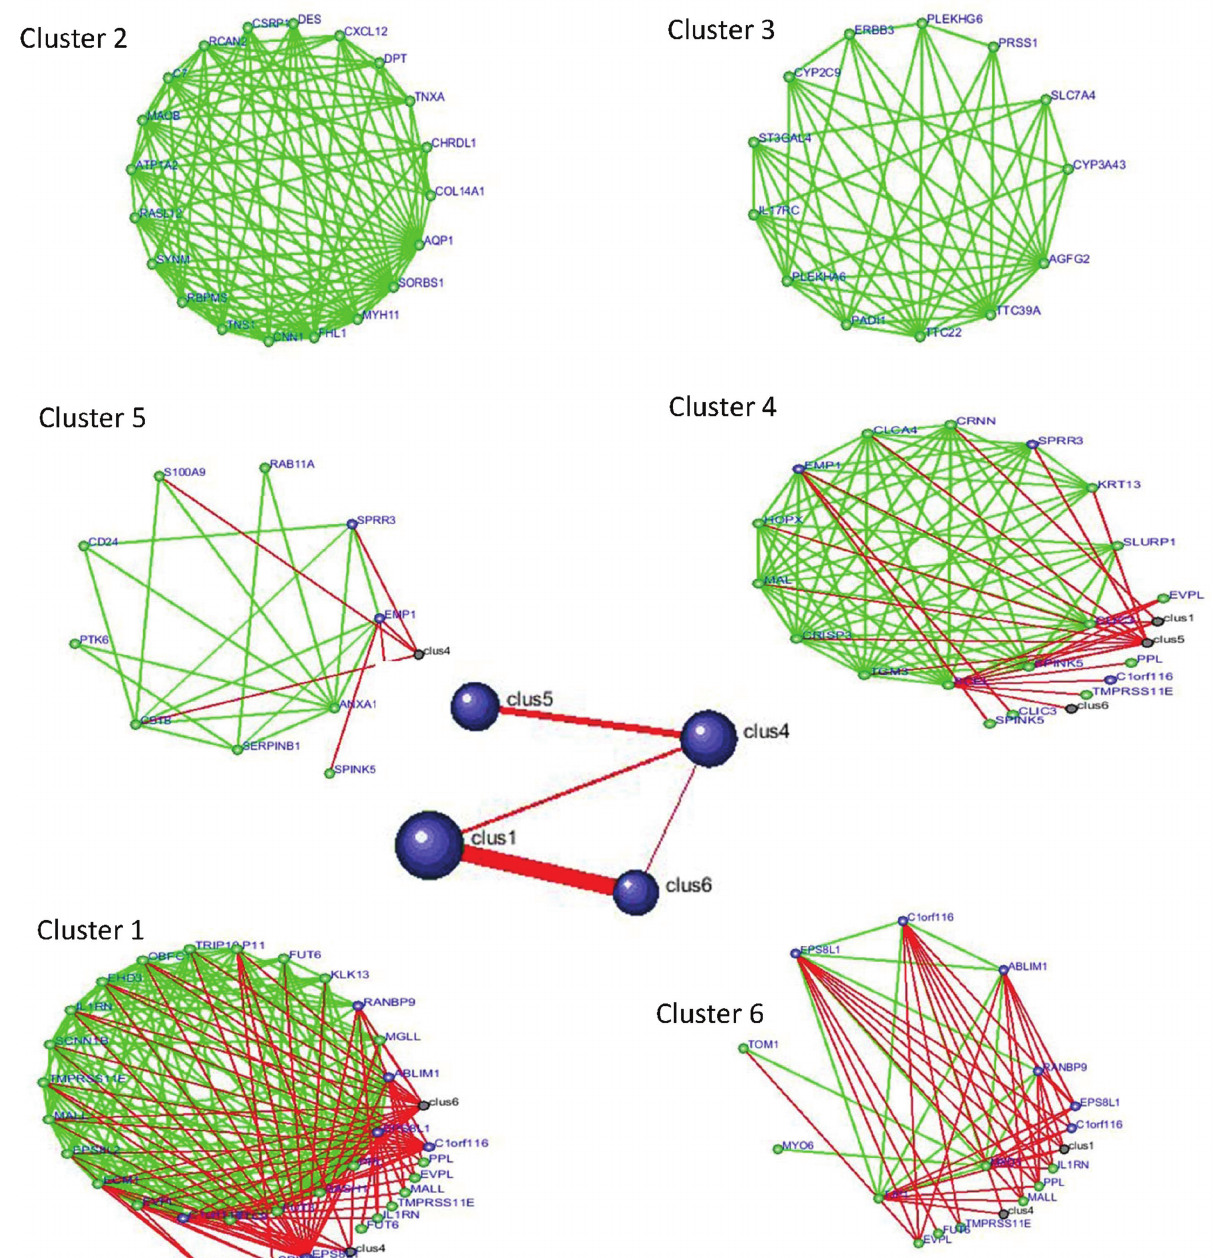
Figure4 -Graph-clusteringofcorrelatedmodulesinESCC(thresholdr=0.9).Redlinesmeanconnectionswithotherclusterscontainingthesamegenes, and green lines connections within the current cluster, without outside